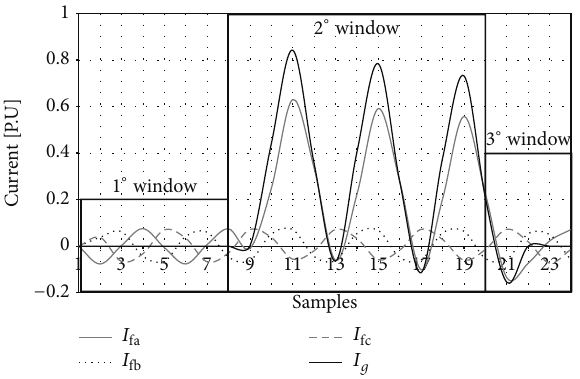
Figure 6: Failure voltages in the different phases and in neutral. Figure 7: Failure currents in the different phases and in neutral.